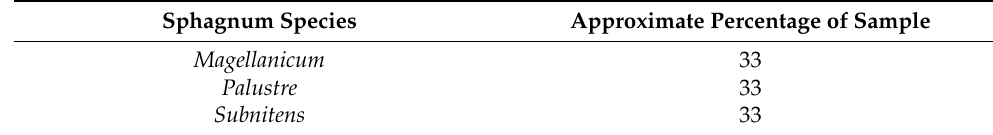
Table 2. Sphagnum Species Distribution Per Sample.